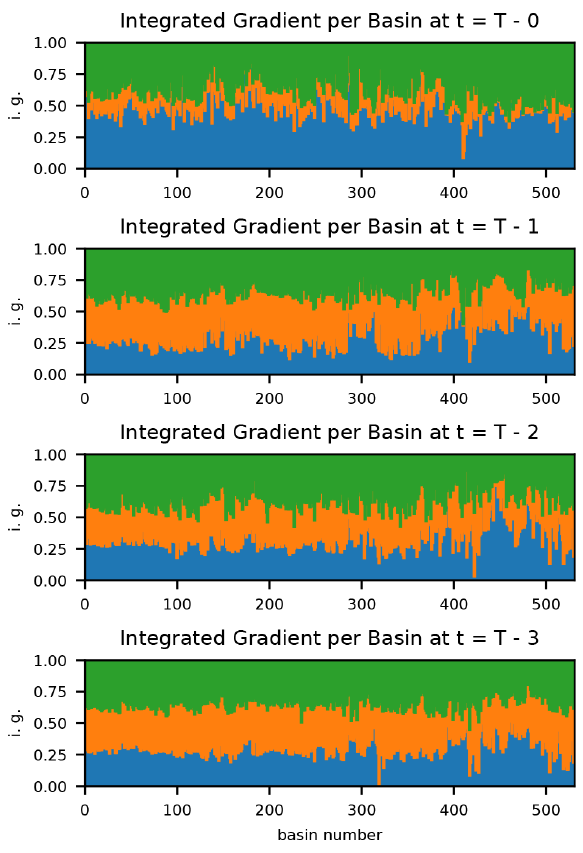
Figure 7. Expansion of Fig. 6 by individual basins and truncated at a lag of s = 3. The relative importance of Daymet is shown in blue, Maurer in orange, and NLDAS in blue. The multi-forcing LSTM combined the precipitation products in different ways in different basins. Daymet is generally more important in high-number basins located in the Pacific